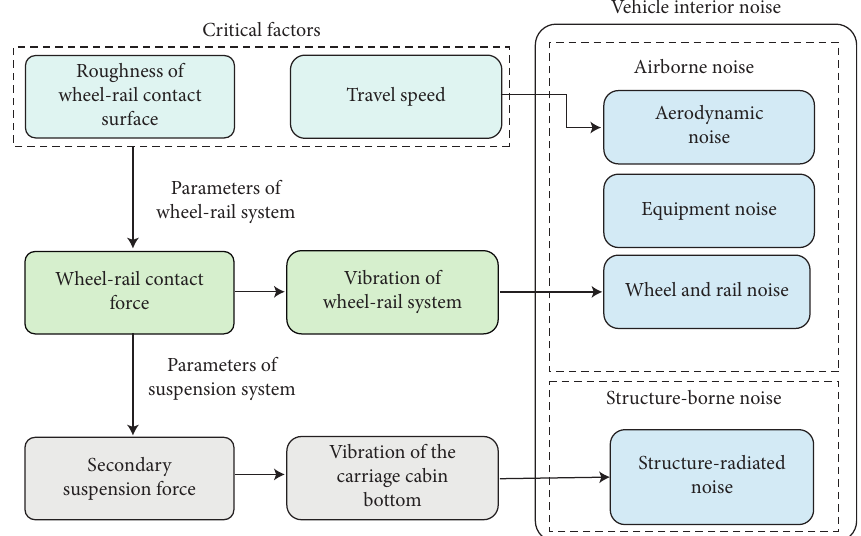
Figure 1: The composition of vehicle interior noise and some critical influencing